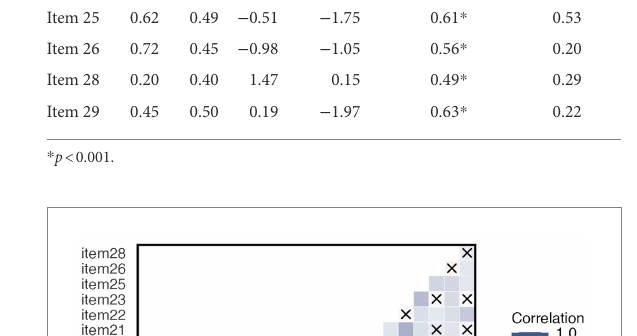
Figure 2; Supplementary Table S1 depict the inter-item correlation coefficients. Bartlett’s test of sphericity (Bartlett, 1954), χ 2 (253) = 715.08, p < 0.001 indicated the correlations between items are adequate for the EFA. However, only 15.42% of the inter- item correlation coefficients were greater than |0.30| in the obtained matrix. The corrected item-total correlations ranged between 0.08 and 0.53 (Table 1). Such a low to moderate item-total correlation was also evident in the original scale, ranging between 0.11 and 0.48 (Rotter, 1966). As such, all items were retained.